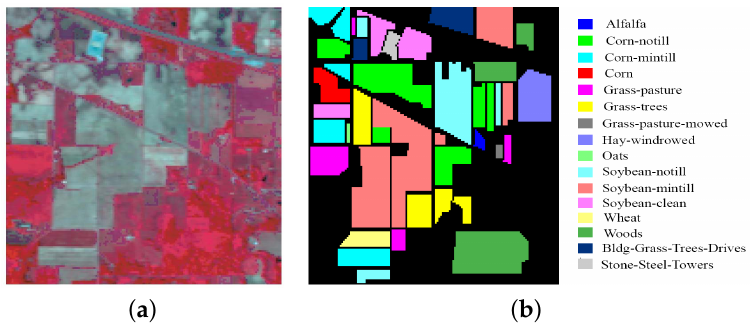
Figure 2. IP data set: ( a ) RGB composite image; ( b ) Ground-truth map.